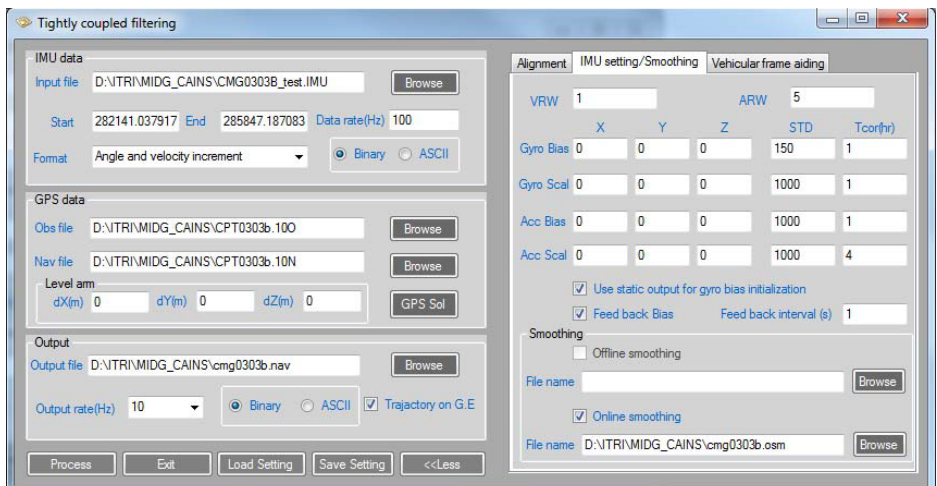
Figure 10. GUI for of tightly coupled integration